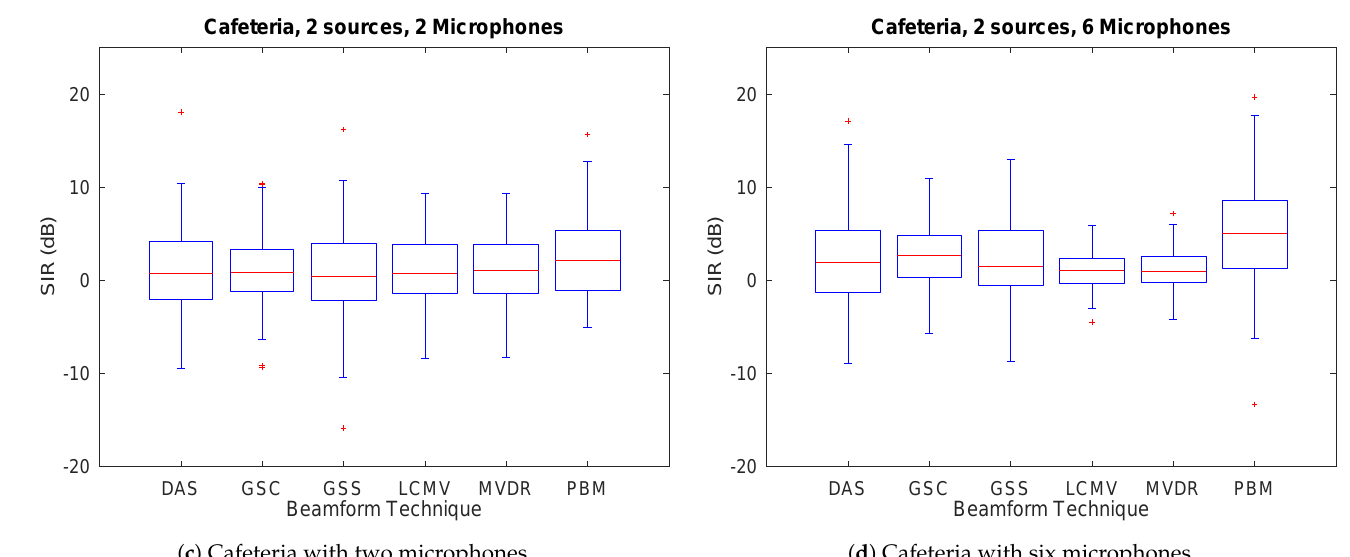
Figure 9. SIR variance for each beamforming